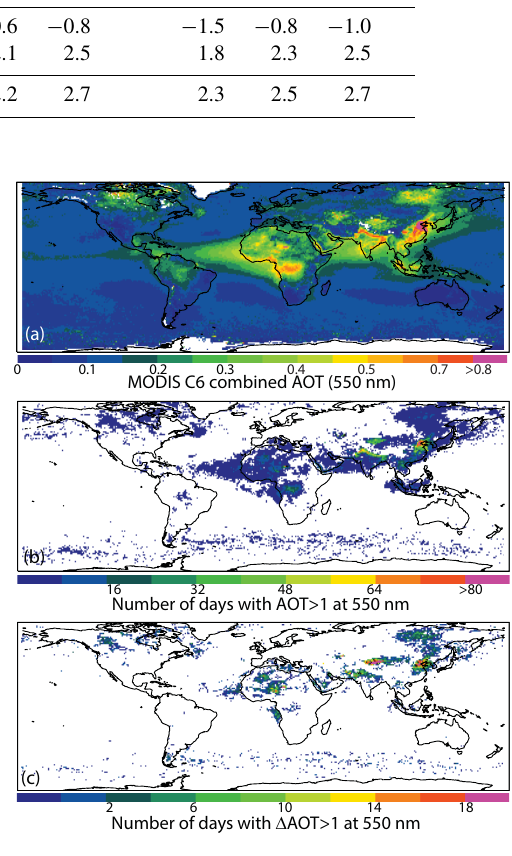
Figure 9. (a) Yearly averaged, 0.5 × 0.5 ◦ (latitude/longitude) binned τ 550 from the Collection 6 Aqua and Terra MODIS com- bined DT and DB aerosol products for 2014; (b) the number of days with daily mean MODIS τ 550 larger than 1 for a given 0.5 × 0.5 ◦ (latitude/longitude) bin; (c) the number of cases when an absolute change in daily MODIS τ 550 of above 1 is detected from two con- tiguous days for a given 0.5 × 0.5 ◦ (latitude/longitude)